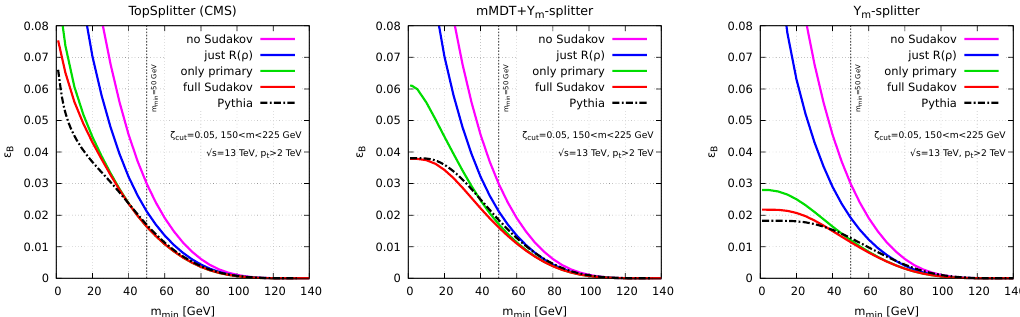
Figure 6. Comparison between analytic results and Pythia simulations for the QCD background e(cid:14)ciency. Results are plotted as a function of the m min cut. For the analytic results, we have included the same levels of approximation to the Sudakov as in (cid:12)gure